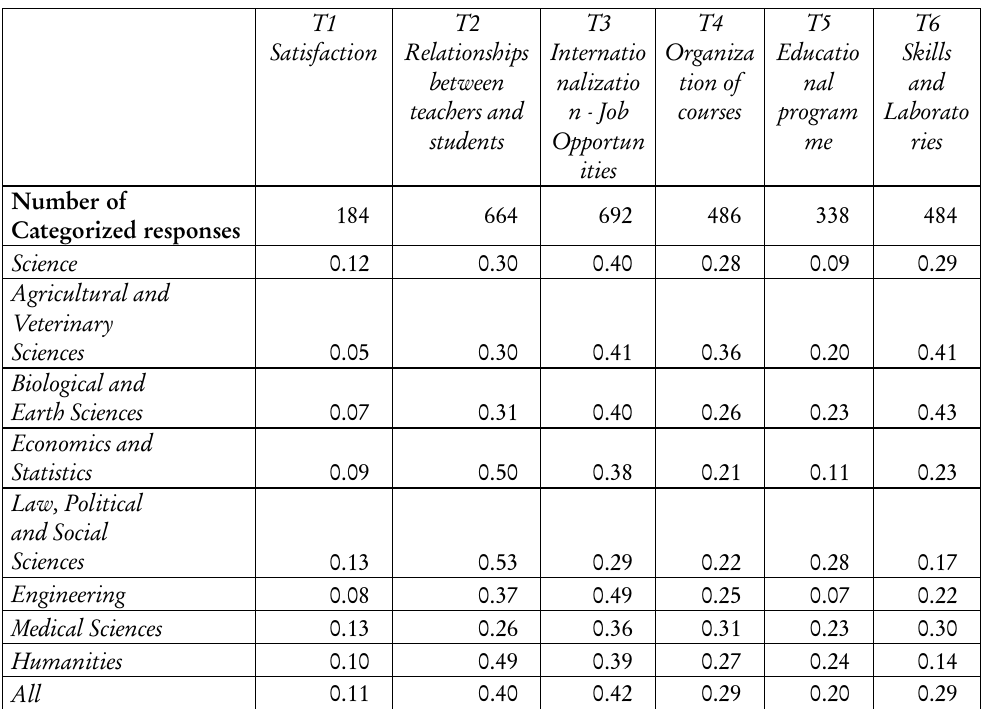
Semantic groups with relative structural modes